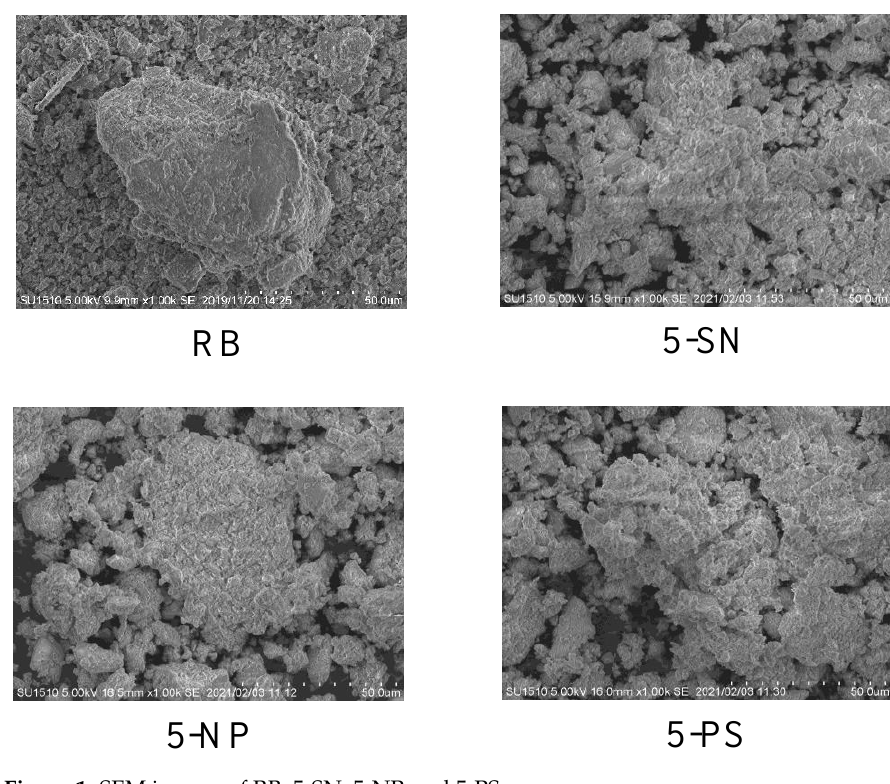
Figure 1. SEM images of RB, 5-SN, 5-NP, and 5-PS.